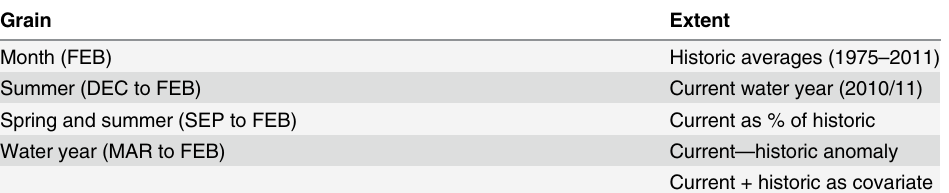
Table 2. Temporal resolutions (grain and extent) evaluated for the meteorological/hydrological vari- ables. All pairwise combinations of grain * extent were tested for modelling spatial variation in the character- istics of drought impact